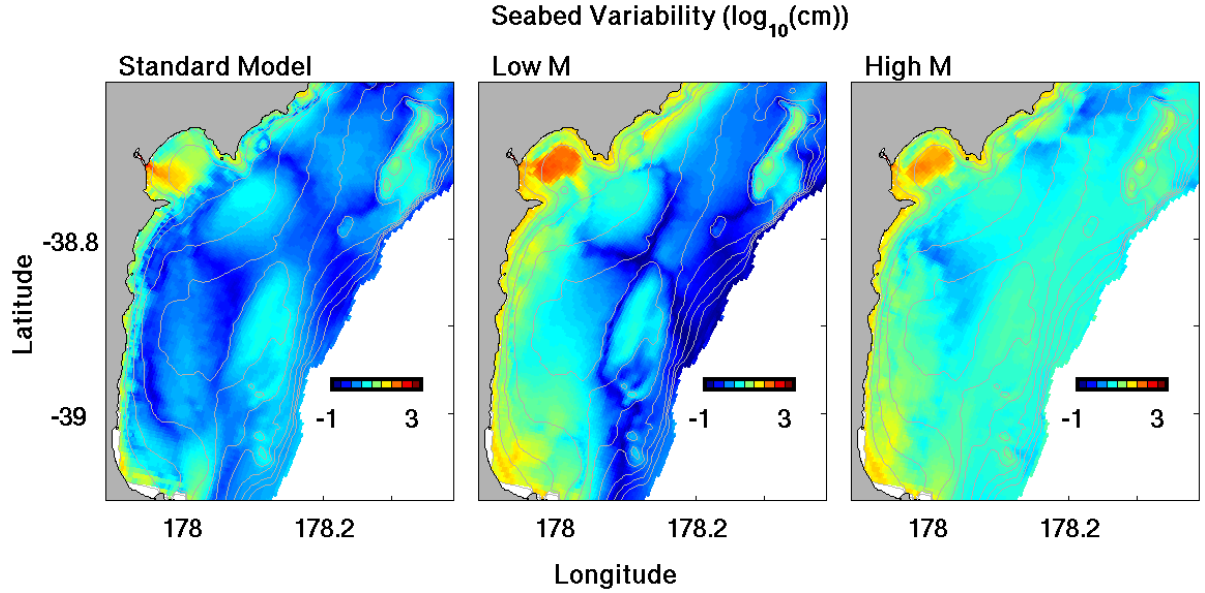
Figure 9. Modeled seabed level variability. Shading indicates log level variability, equal to the standard deviation of seabed thickness (cm) for each grid